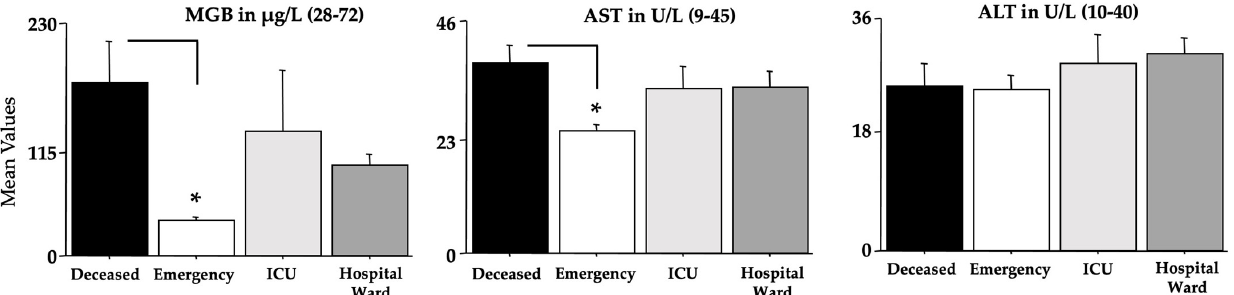
Figure 6. MGB, AST, and ALT in recruited individuals (and relative reference ranges). The error bars indicate the pooled standard error means (SEM) derived from the appropriate error mean square in the ANOVA. The asterisks (* p < 0.05) indicate post hoc differences between groups.